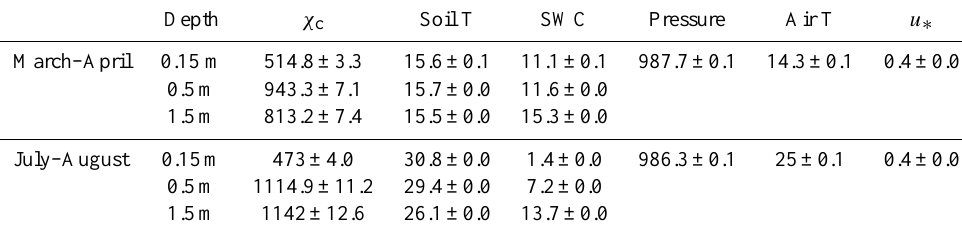
Table 1. Mean±standard error of soil CO 2 molar fractions ( χ c ) , soil temperatures ( T ), soil water contents (SWC), friction velocity ( u ∗ ) , barometric pressure and air temperature during growing (March / April) and dry (July / August) periods of 2010 and